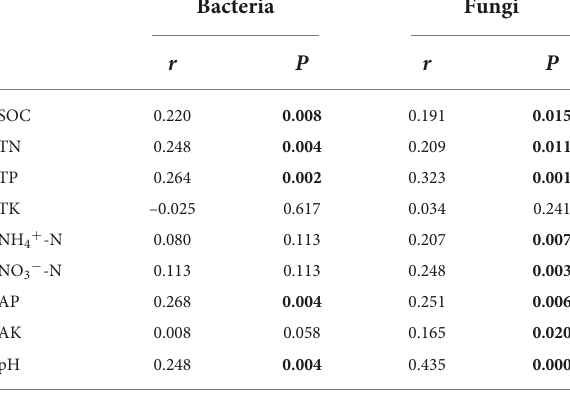
TABLE 4 Mantel analysis of the relationships between the soil microbial community structure and soil properties. Bacteria